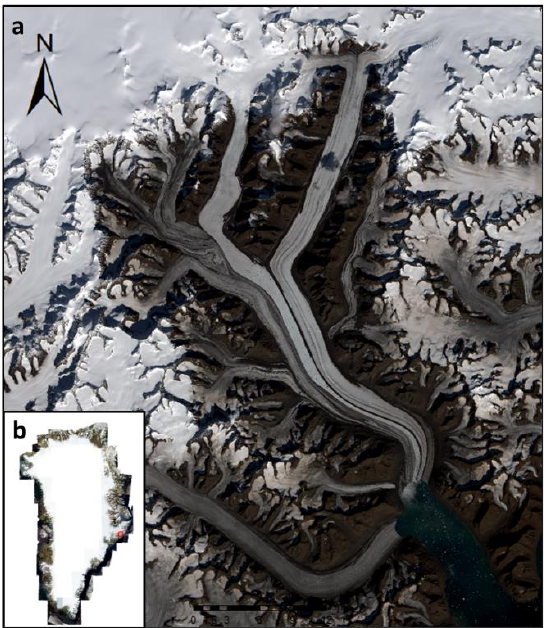
Figure 3 . (a) Overview of Sortebræ Glacier (image from Landsat-8 OLI (band 4,3,2), 20 August 2020). (b) Location of Sortebræ in